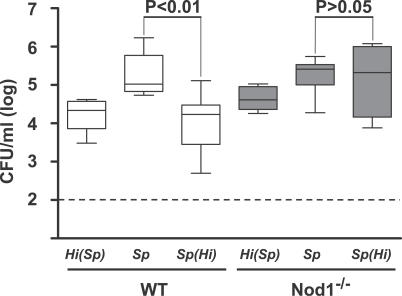
Effect of Nod1 on Competition between Species during Co-ColonizationThe density of Sp1121 (Sp) in upper respiratory tract lavage was determined at 24 h post-intranasal inoculation with Sp alone or together with Hi636 (Hi) in Nod1−/− or parental C57Bl/6 mice (WT). Box-and-whiskers plot indicates high and low values, median and interquartile ranges; n ≥ 10 mice from three independent experiments in each group. Co-inoculated species shown in parentheses. The lower limit of detection for bacteria in lavage culture was 102 CFU/ml (indicated by a dashed line).